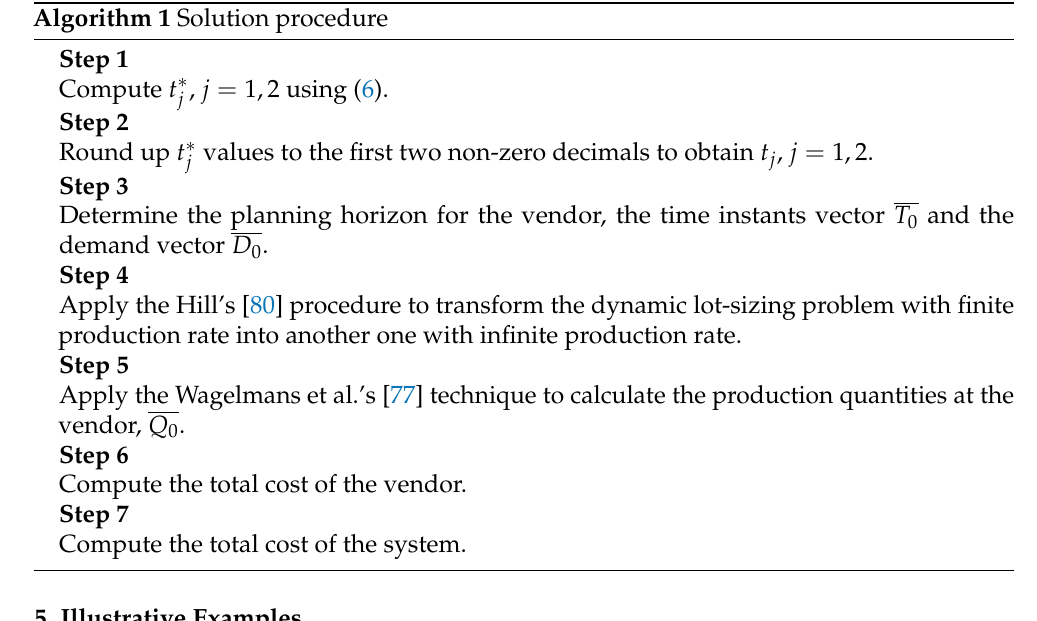
Algorithm 1 Solution procedure